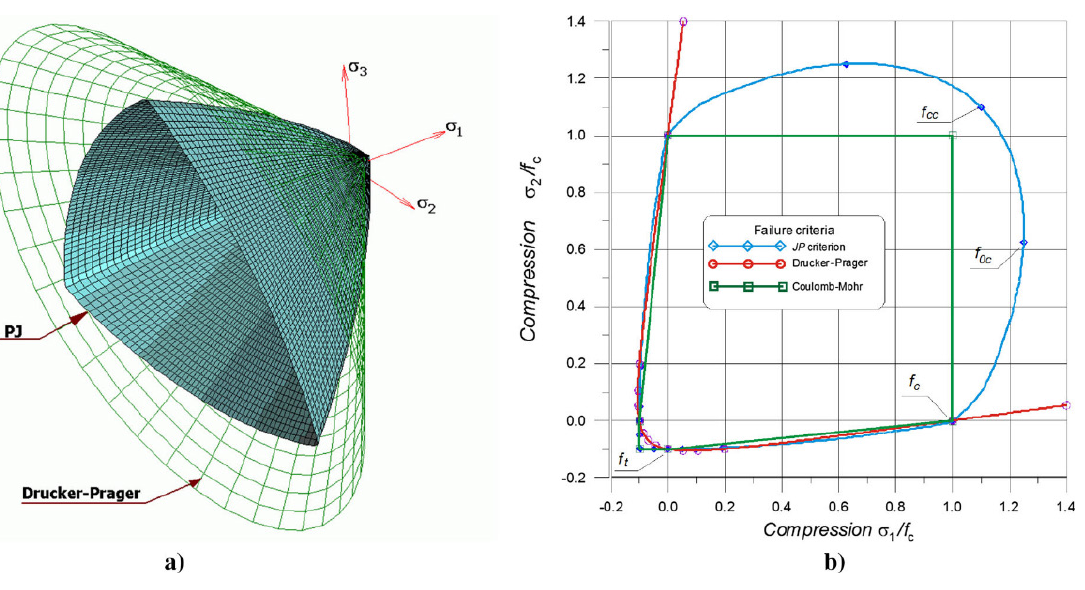
Figure 17: a) The limit surface associated with author Ottosen-Podgórski ( PJ ) criterion compared with Drucker-Prager cone, b) Coulomb- Mohr, Drucker-Prager and PJ criteria at 2D stress